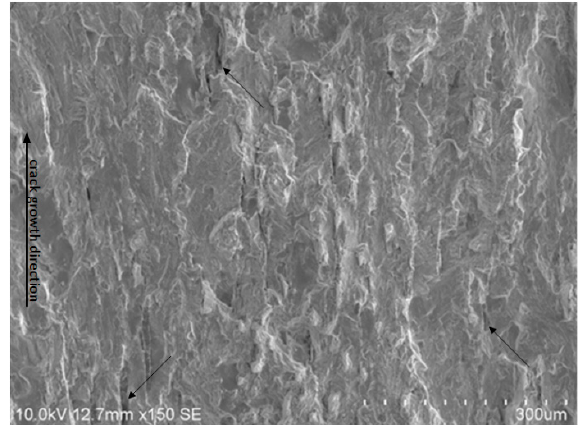
Figure 11. Representative fatigue fracture surface of the broken specimen tested under mode I condition (R = 0.5)—initial fatigue crack growth phase.